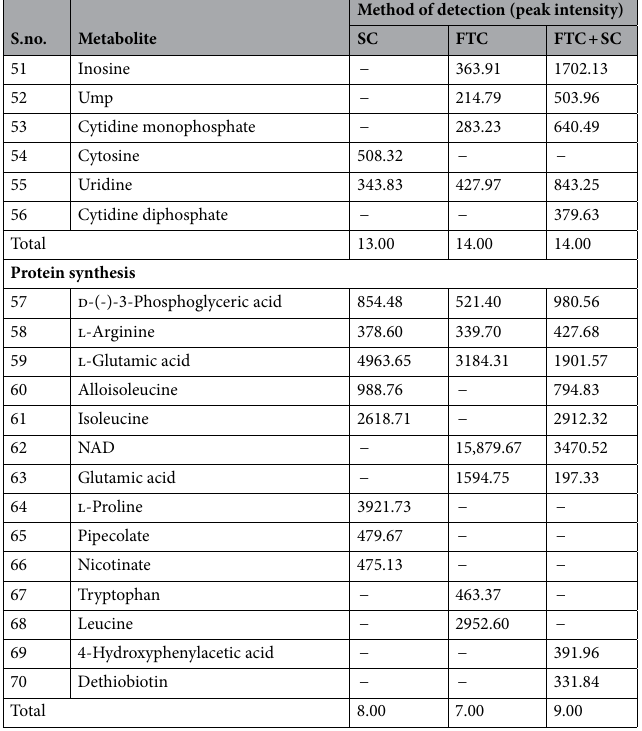
Table 2. List of AMR or it’s associated identified metabolites with peak